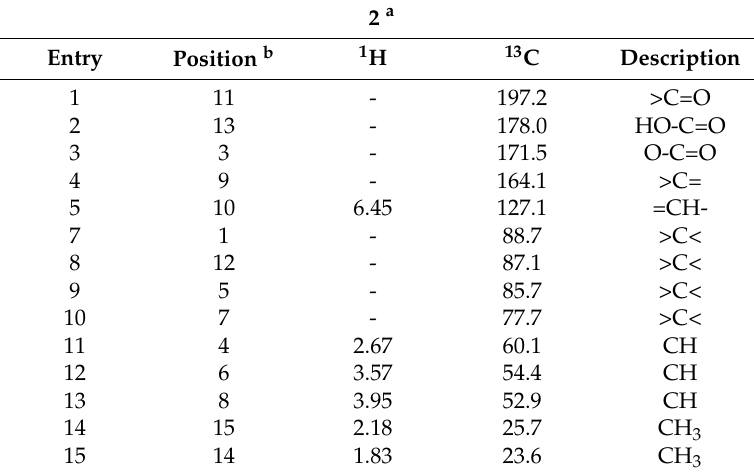
Table 3. 1 H and 13 C-NMR chemical shifts of 2